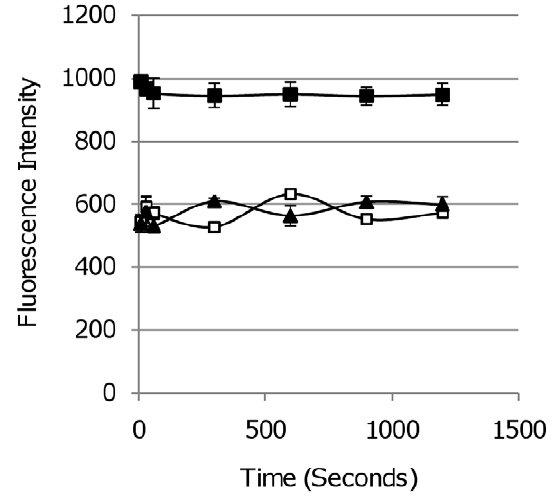
Figure 11. Stability of M.tuberculosis fluorescent strains after long-term excitation. M. tuberculosis transformants expressing FPs from P smyc were grown in liquid medium and the OD 580 adjusted to 0.01. Fluorescence was quantified after excitation over a period of 20 min. ( m ) mCherry, ( & )Turbo-635 and ( % ) tdTomato.